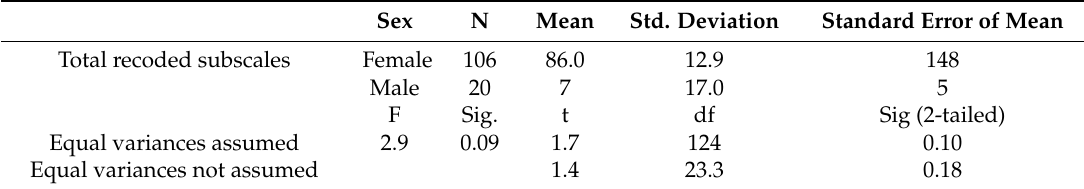
Table 2. Gender and IRMA Score—T-Test for Independent